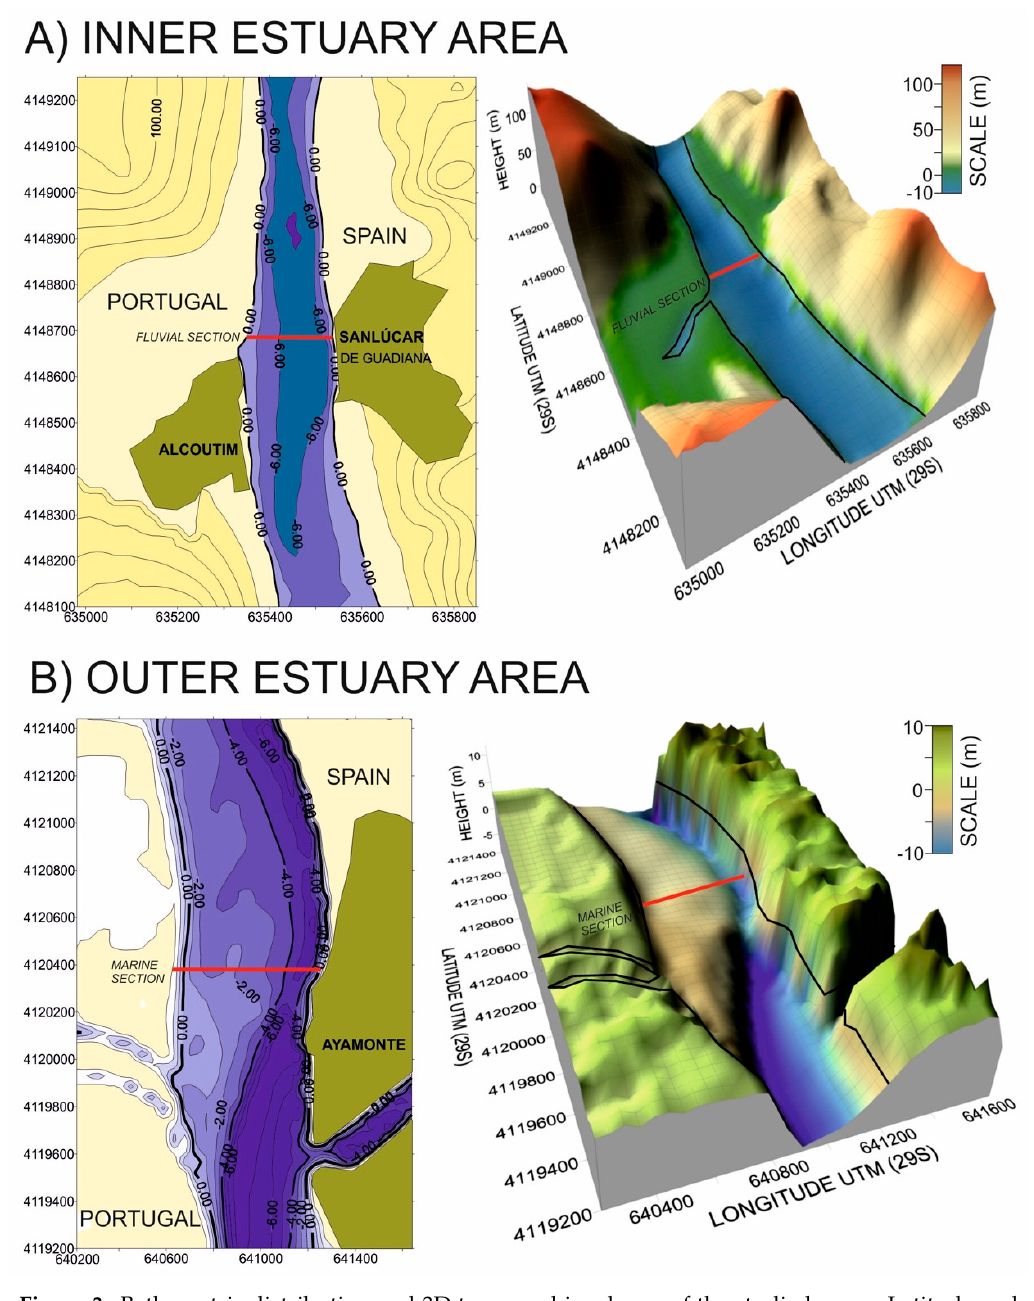
Figure 3. Bathymetric distribution and 3D topographic scheme of the studied areas. Latitude and longitude are expressed in meters, Universal Transverse Mercator coordinates (UTM). ( A ) Inner estuary area and ( B ) outer estuary area.